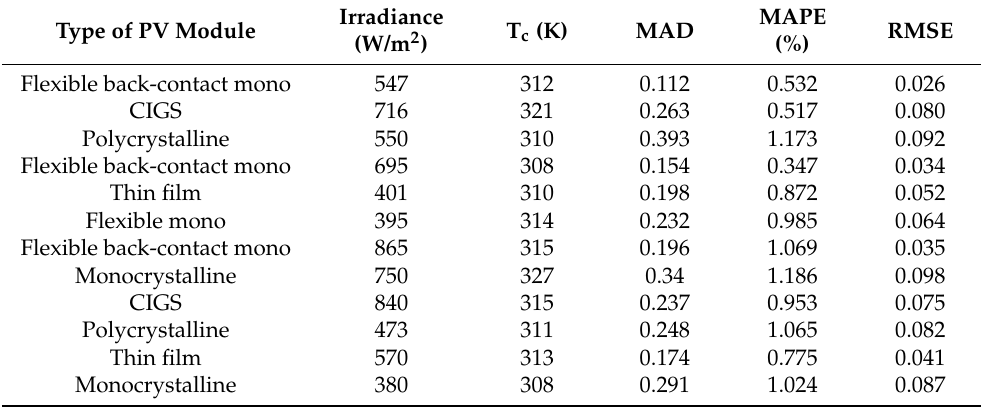
Table 4. Values of MAD, MAPE, and RMSE under different test conditions for the six PV modules. Type of PV